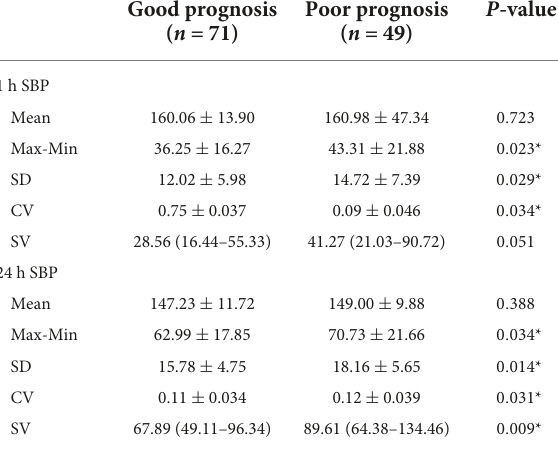
TABLE 1 Univariate analysis of the baseline characteristics of subjects with intracerebral hemorrhage in the good and poor prognosis groups.